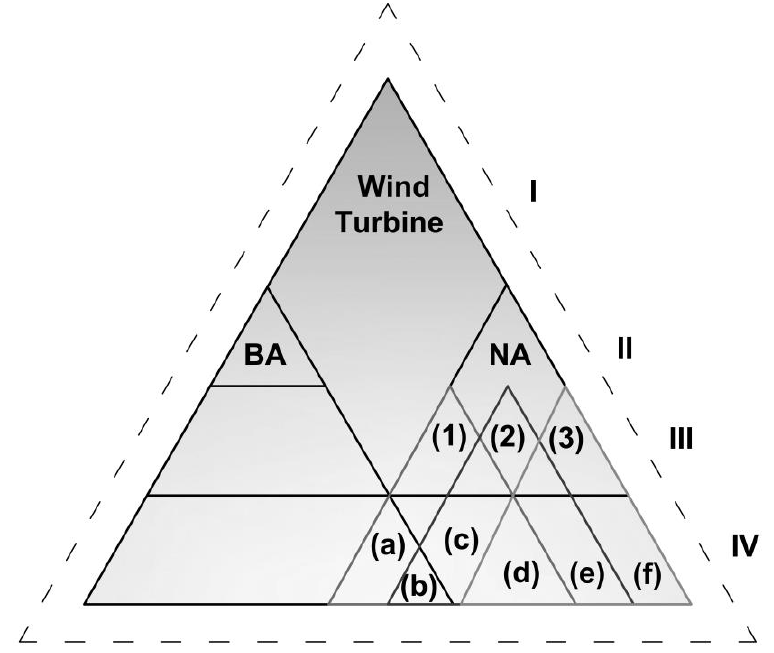
Figure 6. Hierarchical analyses of failures in a wind turbine.